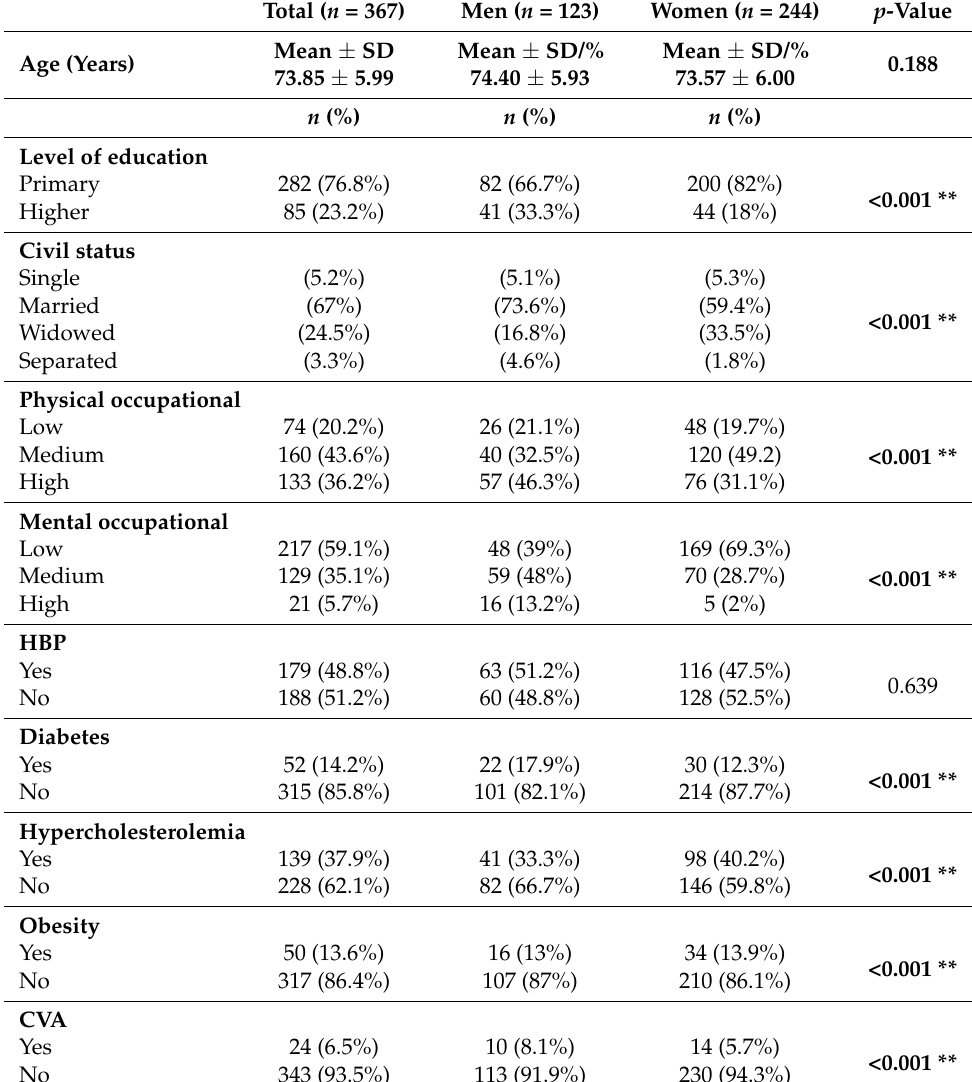
Table 1. The patients’ sociodemographic and clinical characteristics per